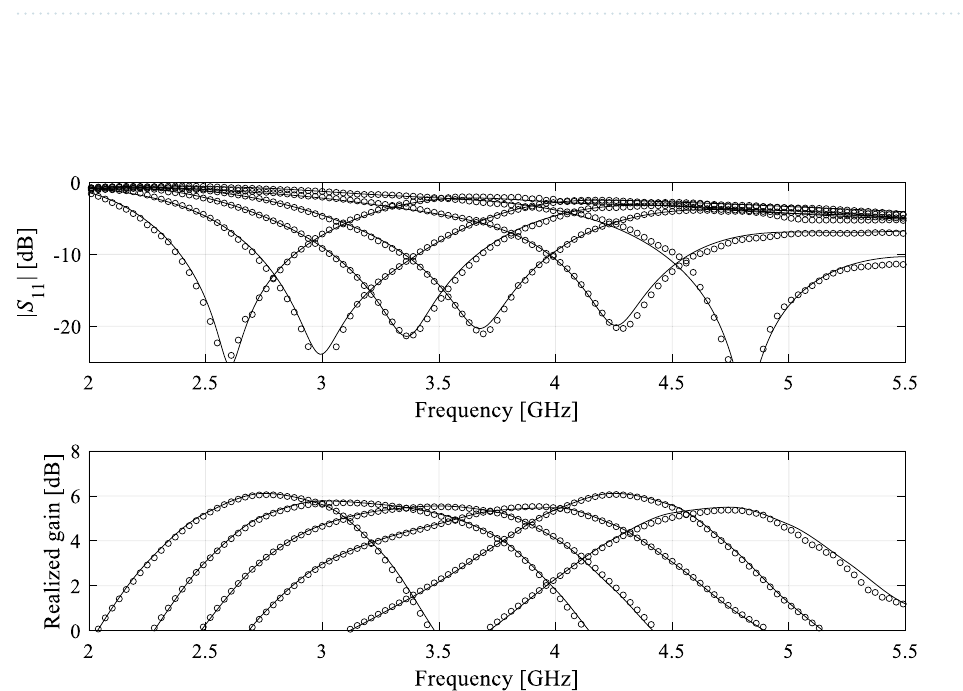
Figure 14. Antenna III: reflection responses at the representative test designs: full-wave model (—), and the presented two-level variable-fidelity surrogate (o) with N Bf = 50 and N Bc =